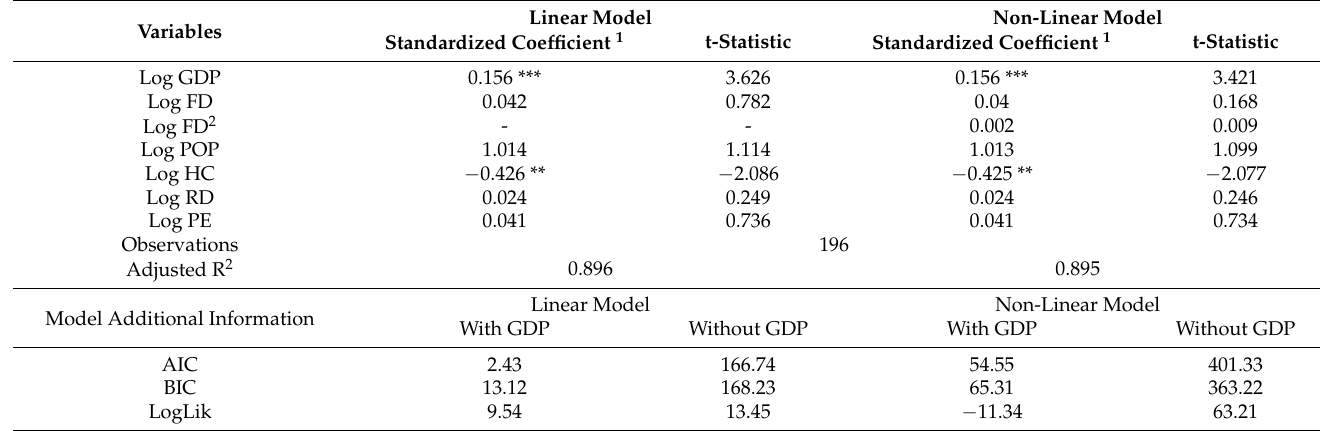
Table 9. Panel data-fixed effect regression results. Dependent variable: EF.